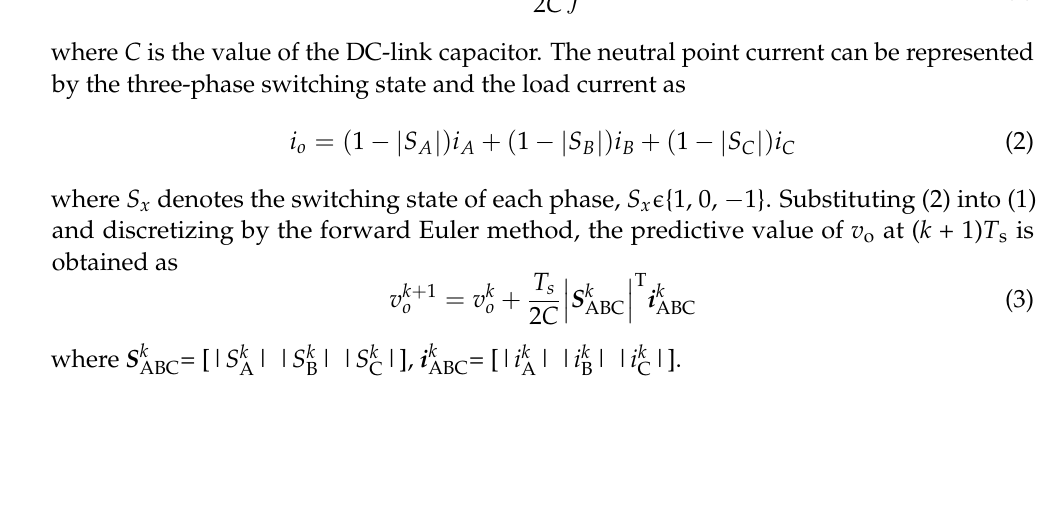
Figure 2. Space vector diagram of NPC three-level converter.